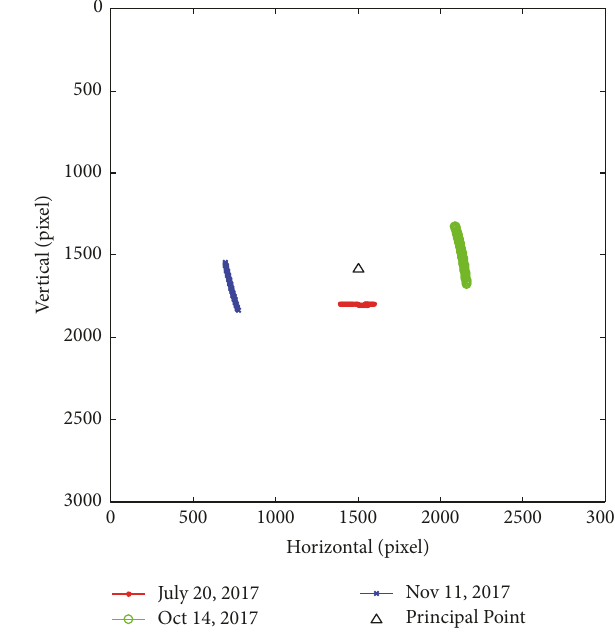
Figure 13: The trajectories of sun image centroids.